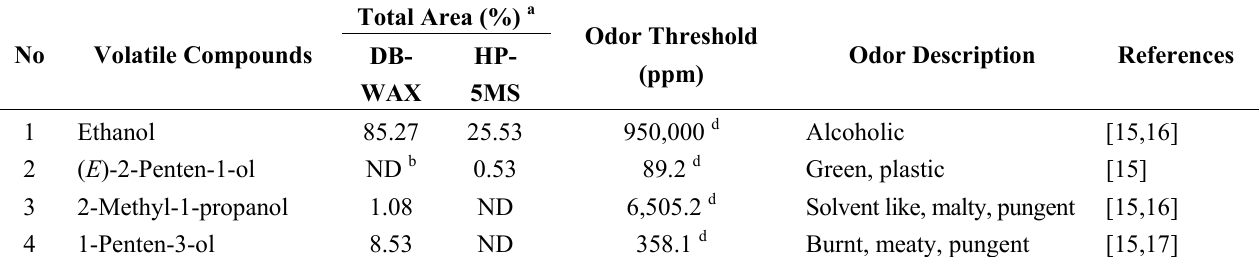
Table 2. Volatile compounds and their odor descriptors of four Budu